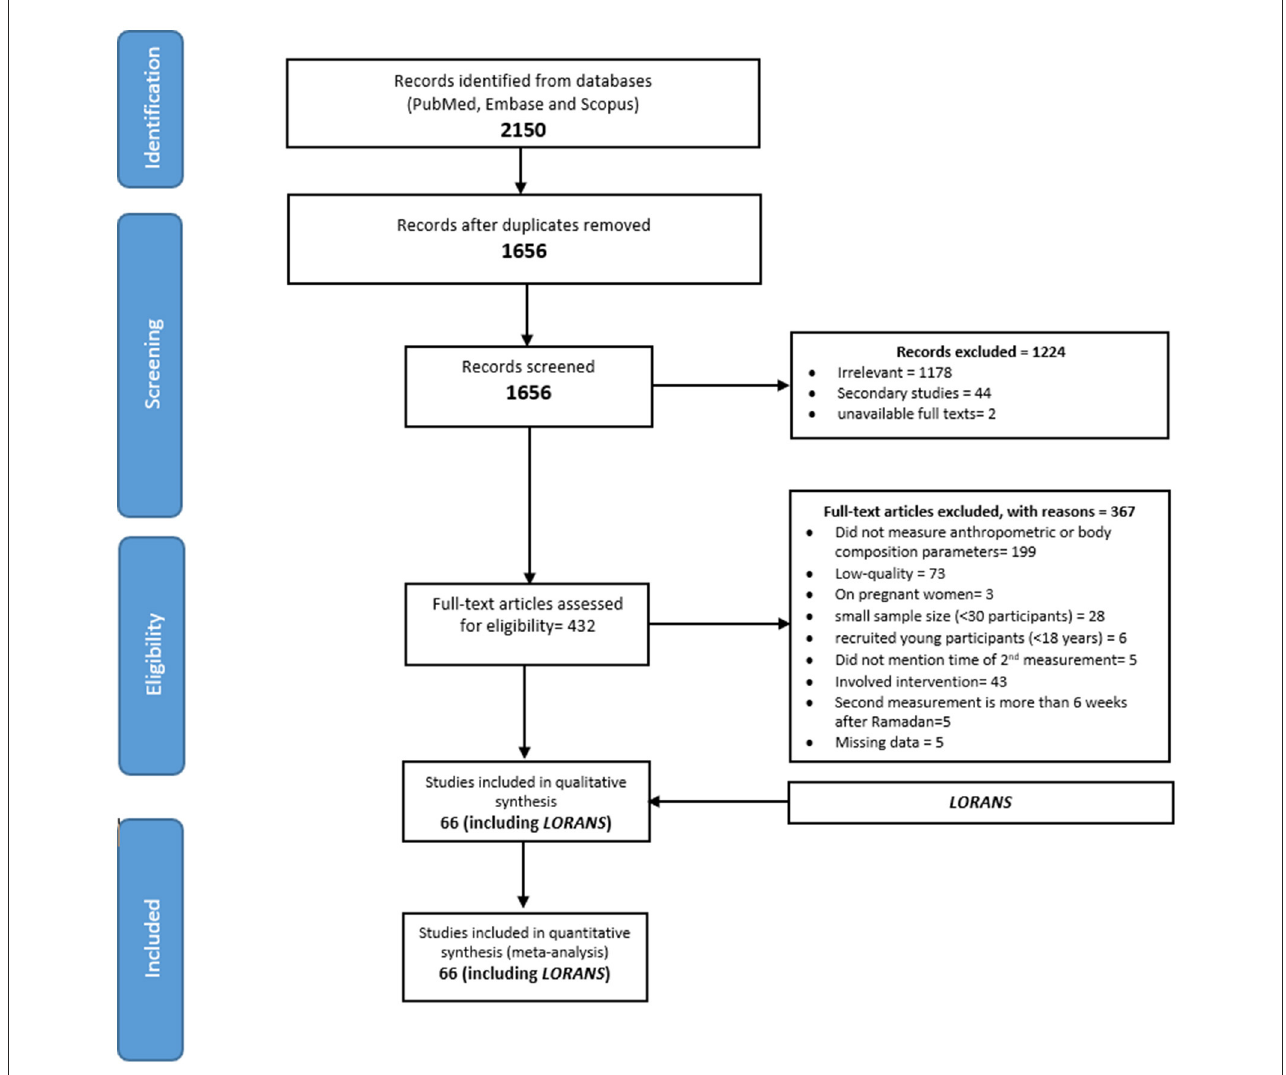
FIGURE2 Flowchart of study